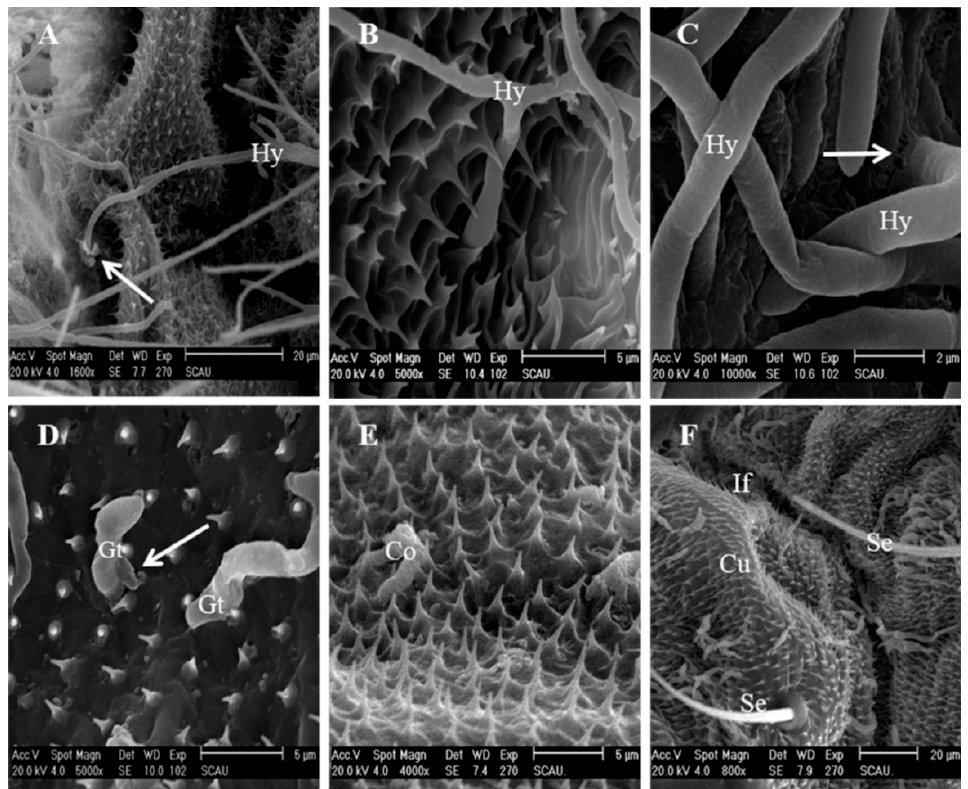
Figure 4. SEM photographs of penetration of Cordyceps fumosorosea on the surface of Plutella xylostella larvae. (A–C) IFCF01; ( A ) A hypha (Hy) was visible at an intersegmental fold piercing through an obvious invasion site (arrow); ( B ) Hyphae (Hy) extended over the cuticular surface (Cu) and invaded by penetration peg (Peg); ( C ) Hypha penetrated at 48 h after inoculation, the penetration site was marked with an arrow; ( D – F ) IFCF-D58; ( D ) Germ-tube (Gt) penetrated through the integument (arrow) at 24 h after inoculation; ( E ) The surface of ungerminated, non-viable conidia was strongly shriveled at the thoracic dorsal; ( F ) The intersegmental fold (If), setae (Se), and large numbers of acanthae are shown in the cuticle (Cu); Malformed hyphae on the cuticle and around the seta (Se), 36 h after